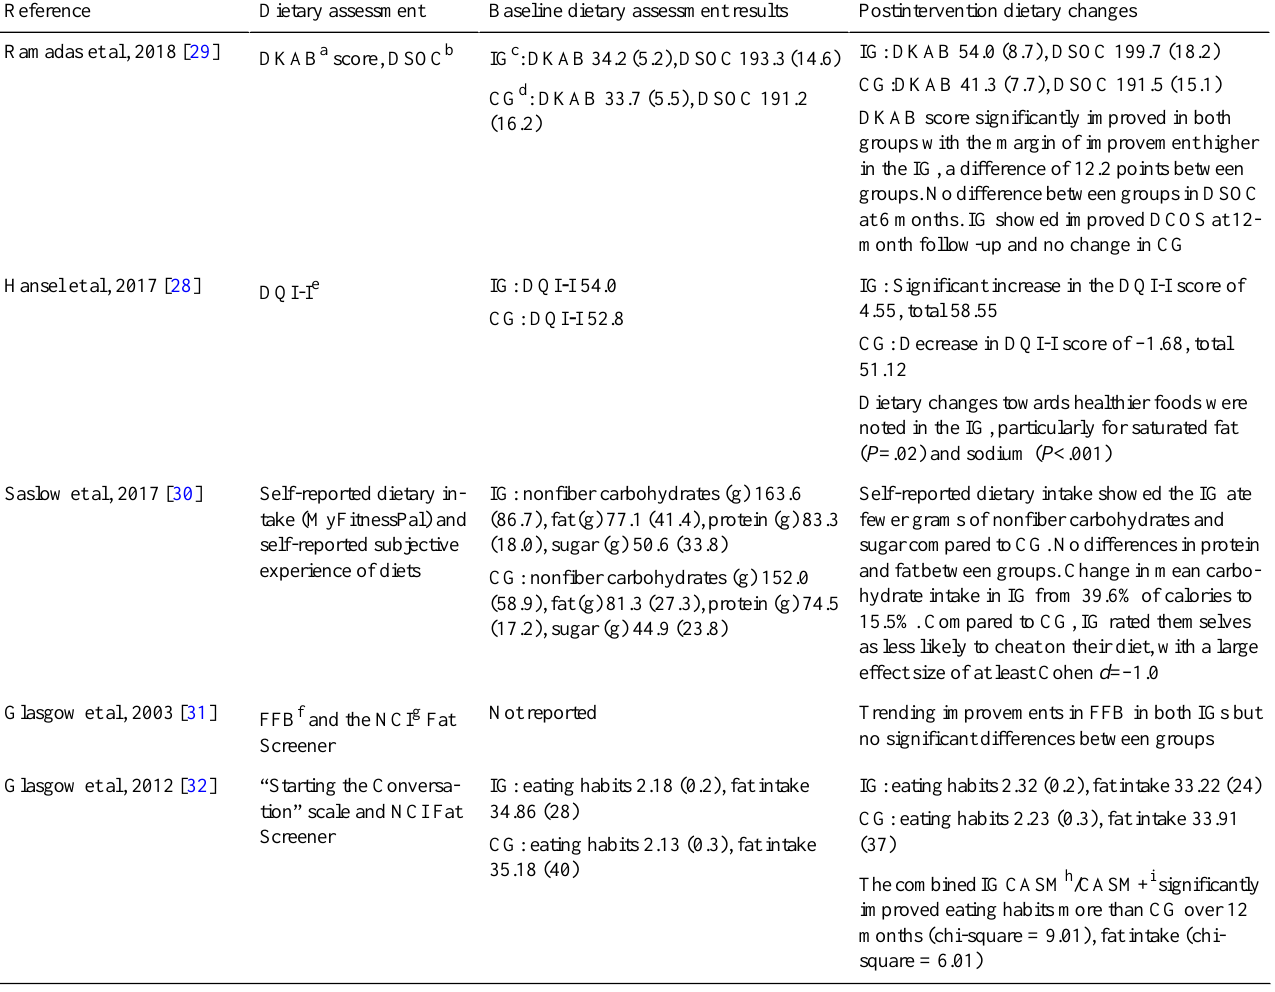
Table 2. An overview of dietary behavioral outcomes.